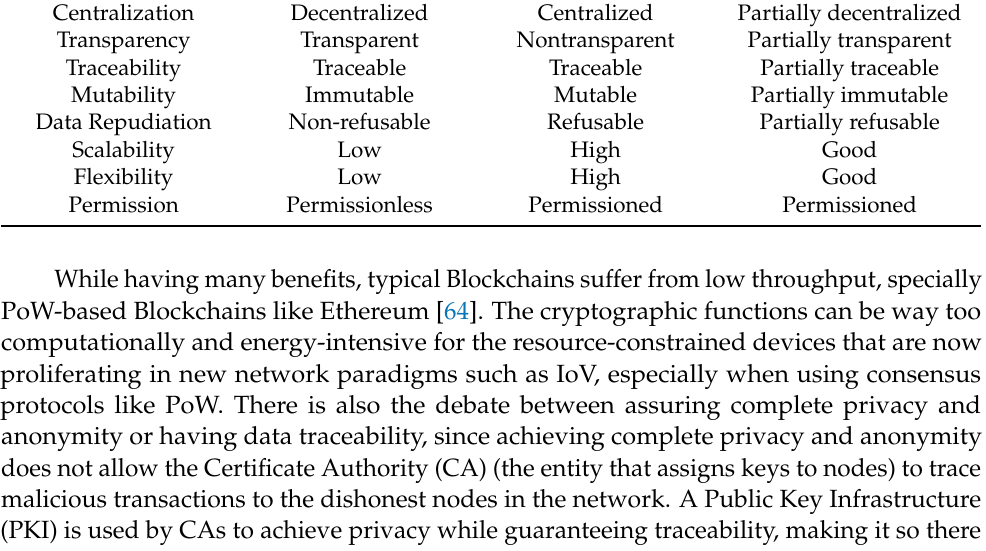
Table 2. Summary of comparison between types of Blockchain. Type of Blockchain Property Public Private Consortium Centralization Decentralized Centralized Transparency